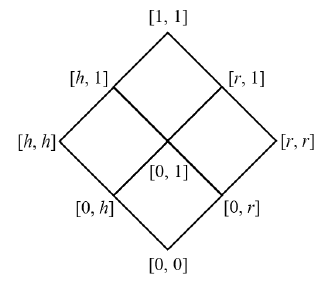
Figure 1. Structure of algebra in Example 5.